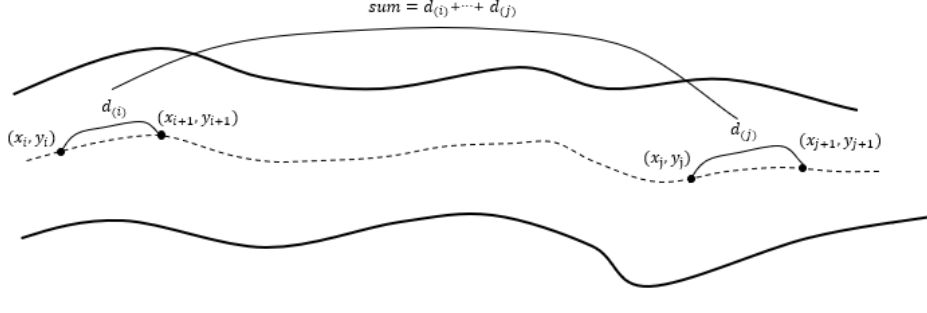
Figure 9. The crack length calculation schematic.